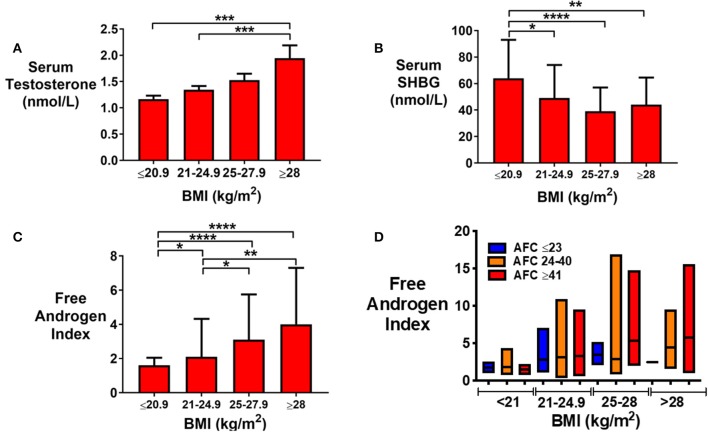
(A) Bar graph (median ± IQR) of serum testosterone (nmol/L) by categories of BMI (kg/m2). Groups were compared by the Kruskal-Wallis test with post-hoc Dunn's multiple comparison test. Serum testosterone was increased by category of BMI. ***P < 0.001. (B) Bar graph (median ± IQR) of serum sex hormone binding globulin, SHBG (nmol/L) by categories of BMI (kg/m2). Groups were compared by the Kruskal-Wallis test with post-hoc Dunn's multiple comparison test. SHBG was reduced in women with higher BMI. *P < 0.05, **P < 0.01, ****P < 0.0001. (C) Bar graph (median ± IQR) of Free Androgen Index, FAI by categories of BMI (kg/m2). Groups were compared by the Kruskal-Wallis test with post-hoc Dunn's multiple comparison test. FAI was increased by BMI category. *P < 0.05, **P < 0.01, ****P < 0.0001. (D) Bar graph (median ± IQR) of FAI by categories of BMI (kg/m2) stratified by AFC. Median and range is presented. FAI in those with AFC 23 are shown in blue, 24–40 in orange and ≥41 in red.